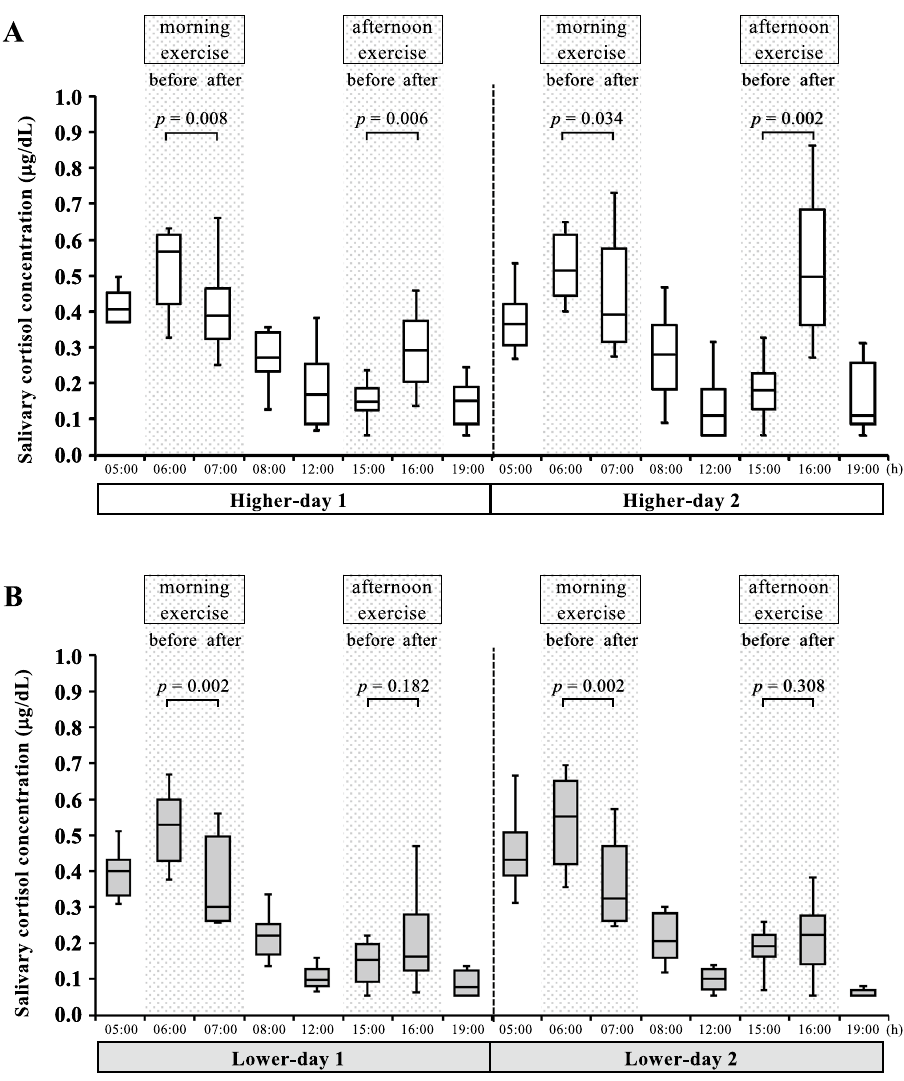
Figure 2. Changes in salivary cortisol concentrations in response to each exercise within the circadian rhythm on 2 consecutive days during the higher-altitude camp ( A ) and lower-altitude camp ( B ). The white box plots denote the cortisol concentration at the higher-altitude camp, whereas the gray box plots represent those at the lower-altitude camp. The gray dot squares denote the time of exercise at each camp. The significant differences between two time points of each exercise for runners were analyzed using the Wilcoxon signed-rank test. Higher-day 1, day 1 at the higher-altitude camp; Higher-day 2, day 2 at the higher-altitude camp; Lower-day 1, day 1 at the lower-altitude camp; Lower-day 2, day 2 at the lower-altitude camp.